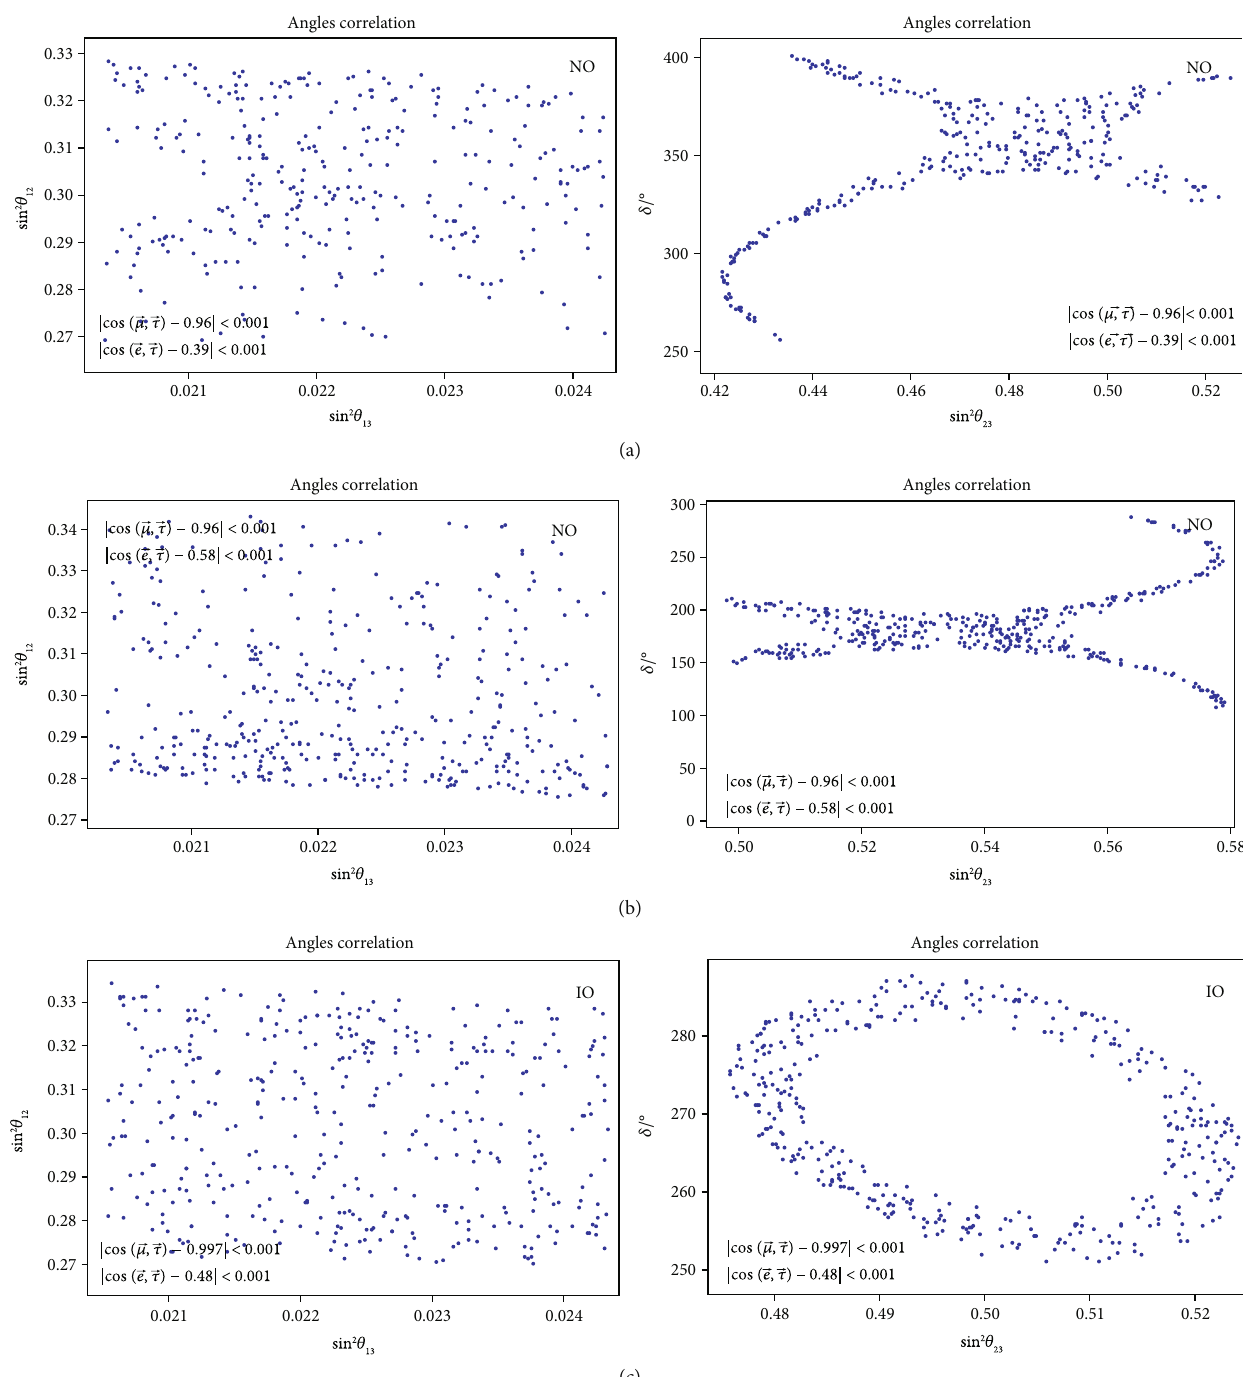
! Þ ! Þ ! ! , τ , τ , cos ð e ) listed in 0 0 0 0 ! Þ − ! , τ 0 : 39 j < 0 : 001 . (b) NO case with the constraints ! Þ − ! Þ ! ! , τ 0 : 997 j < 0 : 001 and j cos ð e , τ